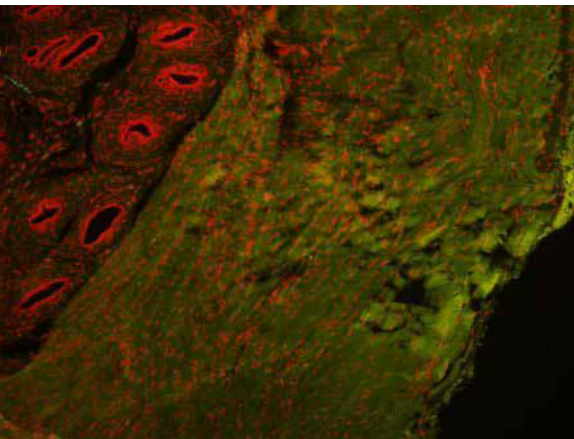
figure 1 - Group I. Microscopic fluorescence immunohisto- chemistry for the detection of active caspase-3. Increase 10x.